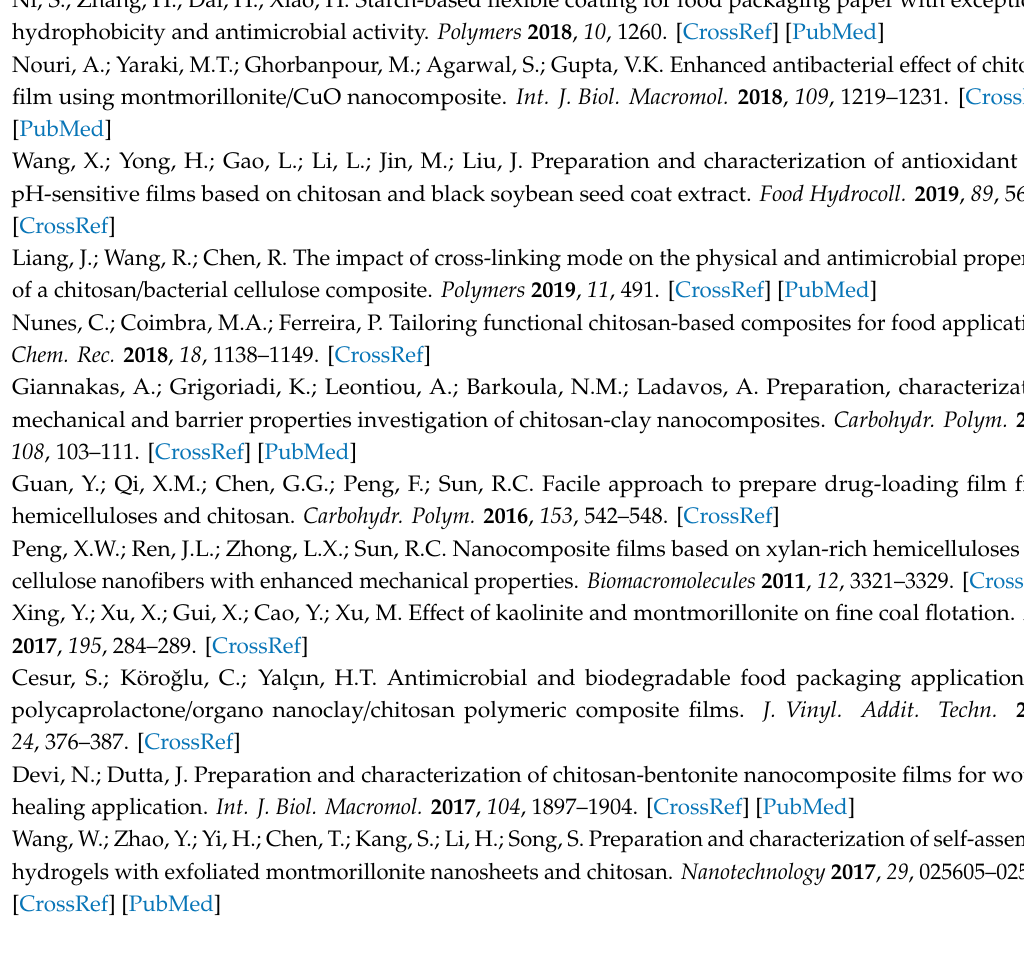
Table S1: Concentration of hemicellulose-derived saccharides in poplar hot water extract. (HWE concentration is 22.6 g / L), Table S2: Compositions (wt % total saccharides) of poplar hot water extract, Figure S1: The TEM image of BT (a), particle size distribution diagram of BT (b), CS-BT 10 (c), CS-BT-HWE 10 (d), Figure S2: The presentation for the color of the mixture solution with di ff erent amounts of HWE added in the CS-BT-HWE system. (a) the water-BT-HWE system of which the chitosan in the CS-BT-HWE system was substituted by an equal volume of deionized water; (b) the initial CS-BT-HWE mixture solution before reaction; (c) the CS-BT-HWE system reacted at room temperature for 10 h (From left to right, the HWE amount is 10%; 20%; 30%, 40%, respectively.), Figure S3: The absorbance of the initial CS-BT-HWE mixed solution ( ) and mixing for 10 h ( ) (n =